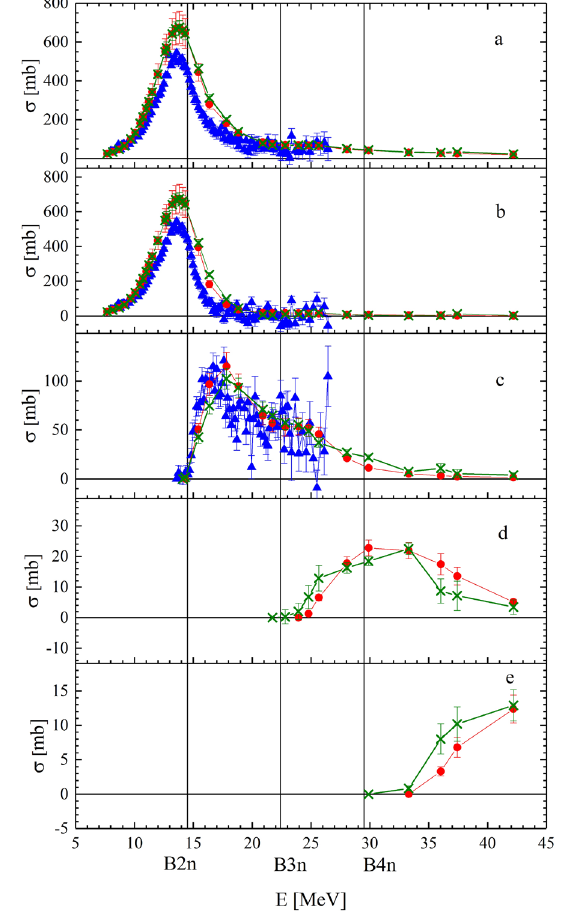
Figure 2. 209 Bi experimental cross sections obtained at Liver- more ([16] - triangles) in comparison with the evaluated once ([12], circles). Crosses present data obtained by the novel tech- nique of flat-e ffi ciency detector (look further) [17]: (a) σ ( γ, tot ), (b) σ ( γ, 1 n ), (c) σ ( γ, 2 n ), (d) σ ( γ, 3 n ), (e) σ ( γ, 4 n ). data for 209 Bi using the data obtained at Livermore Figure 1. F exp i get [18]. The main conclusion [18] was that evaluated cross sections are in agreement with the results of a pho- ton activation experiment, while the experimental cross- section of the ( γ, 2 n ) [16] is apparently